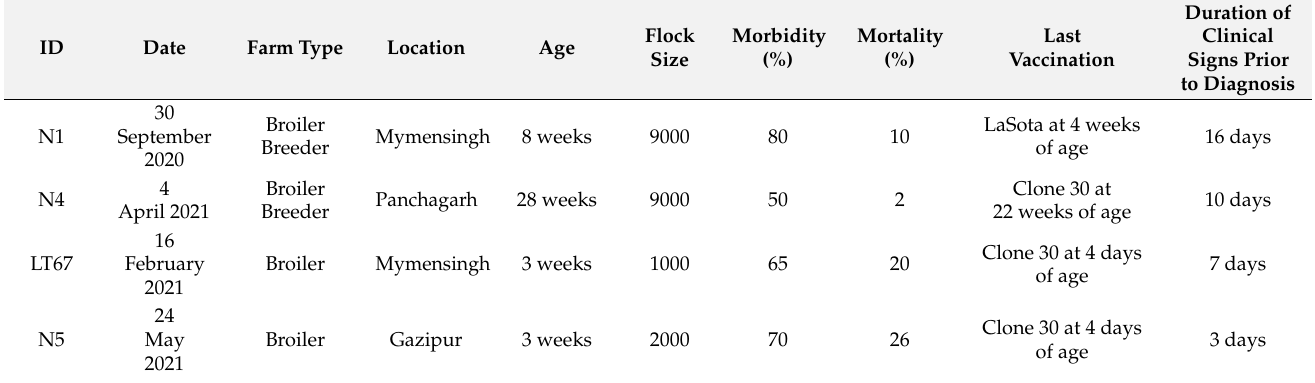
Table 1. Background information data of four Newcastle disease suspected outbreaks in Bangladesh between 2020 and